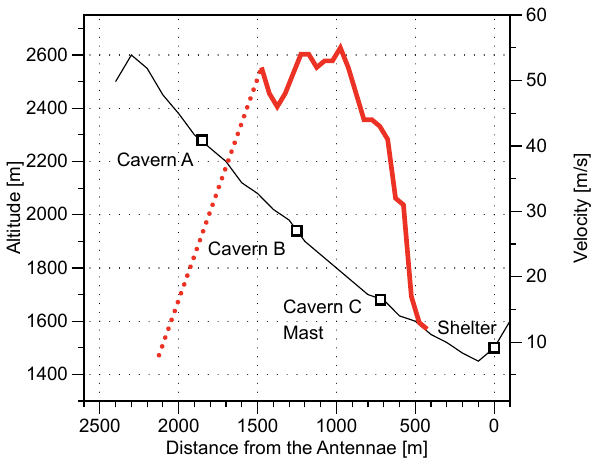
Fig. 5. Avalanche front velocity measured with the PDR for Avalanche 1 (solid red line). Velocity was assumed to grow linearly in time (dotted red line) above Cavern B in the absence of